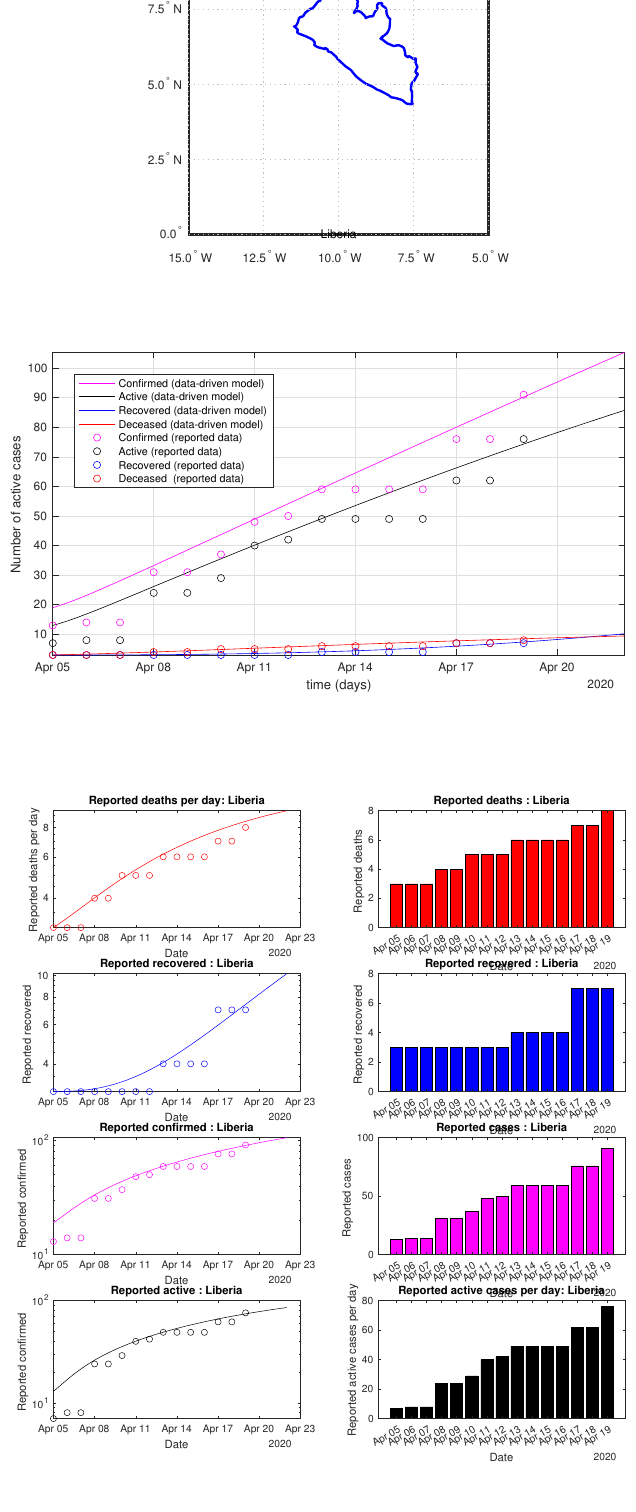
Figure 68. Liberia: data vs.